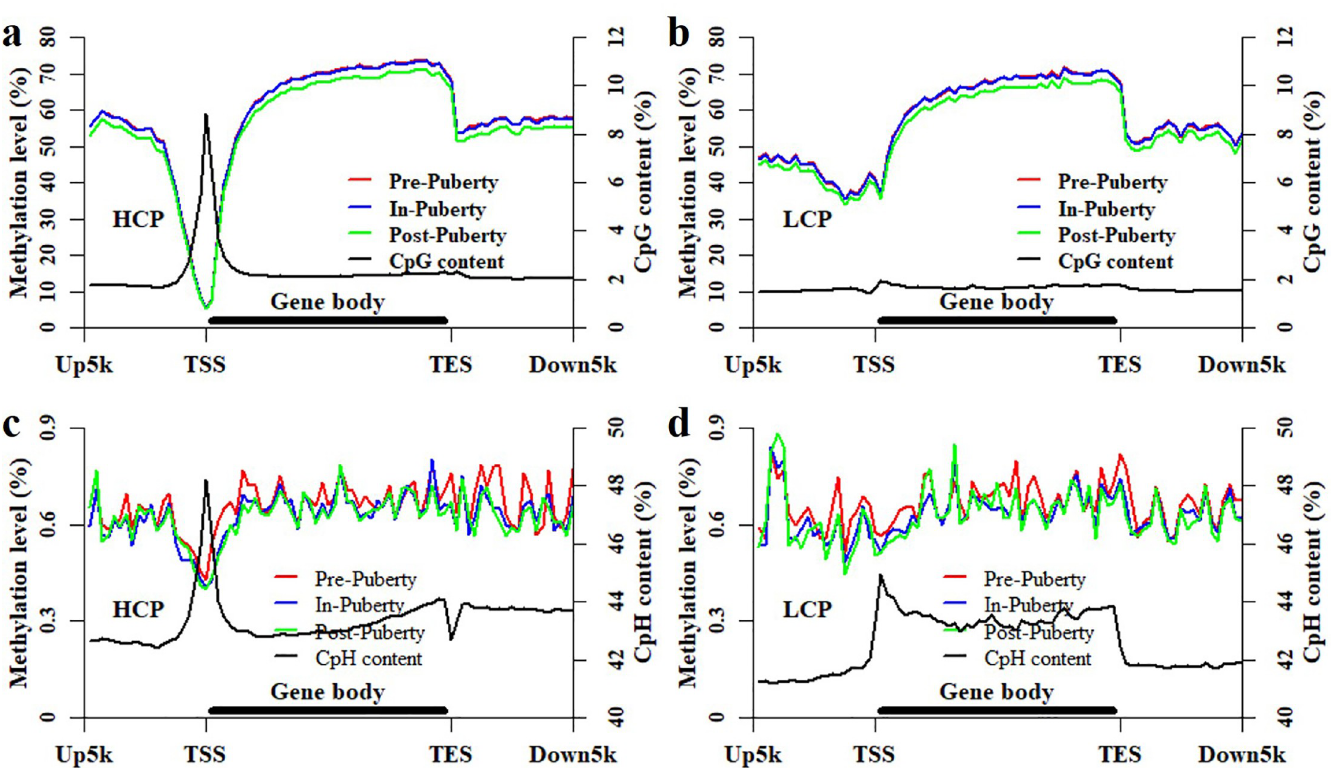
Fig 4. Methylation and density patterns of CpGs and CpHs at the locations of HCP and LCP genes. Methylation and density patterns of CpGs at the locations of HCP ( a ) and LCP ( b ) genes. Methylation and density patterns of CpGs at the locations of HCP ( c ) and LCP ( d ) genes.